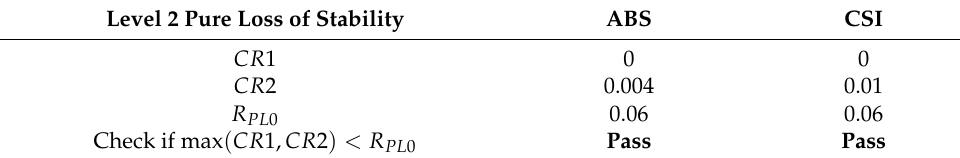
Table 20. Level 2 assessment of pure loss of stability failure mode for C11 container